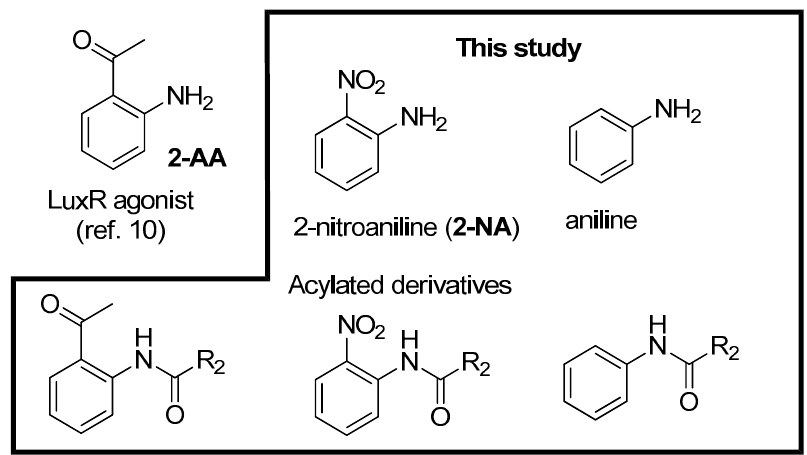
Figure 3. Structure of substituted anilines and their acylated derivatives.